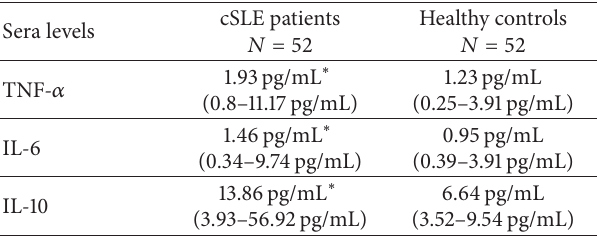
Table 2: Sera cytokines levels of the individuals included in the